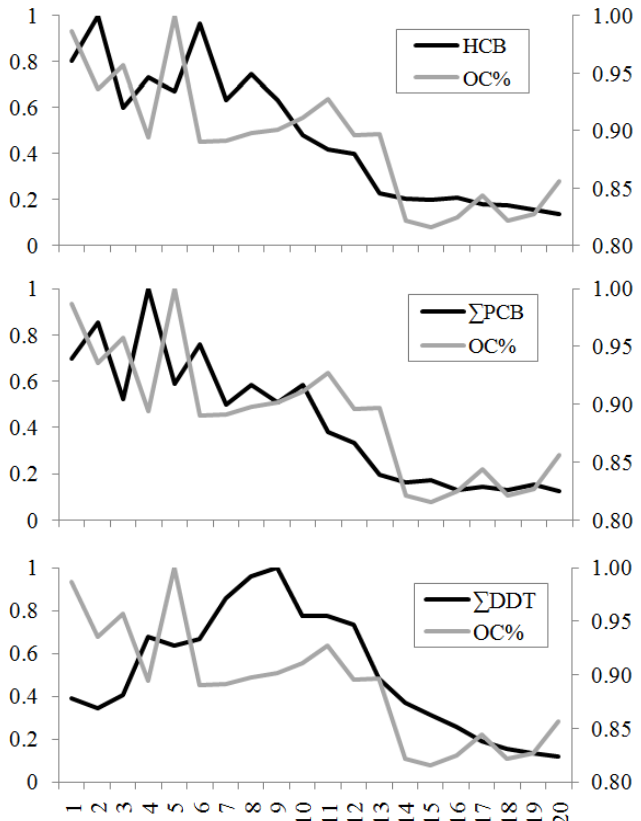
Figure 5. Relative contributions OC%, HCB, ∑ PCBs, and ∑ DDT (OC% and POP concentrations divided by maximum OC% or concentrations in the sediment